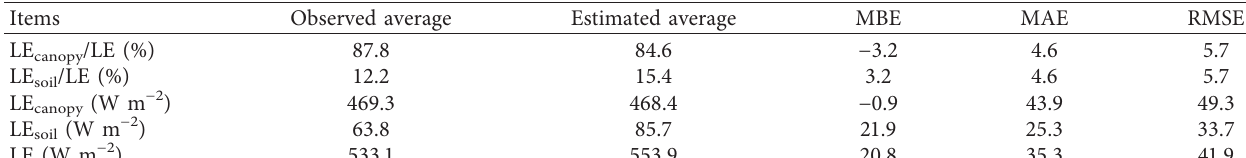
Table 4: Statistics of the ratios of LE canopy to LE (LE canopy /LE) and LE soil to LE (LE soil /LE), LE canopy , LE soil , and LE modeling accuracies of five dates at the DM